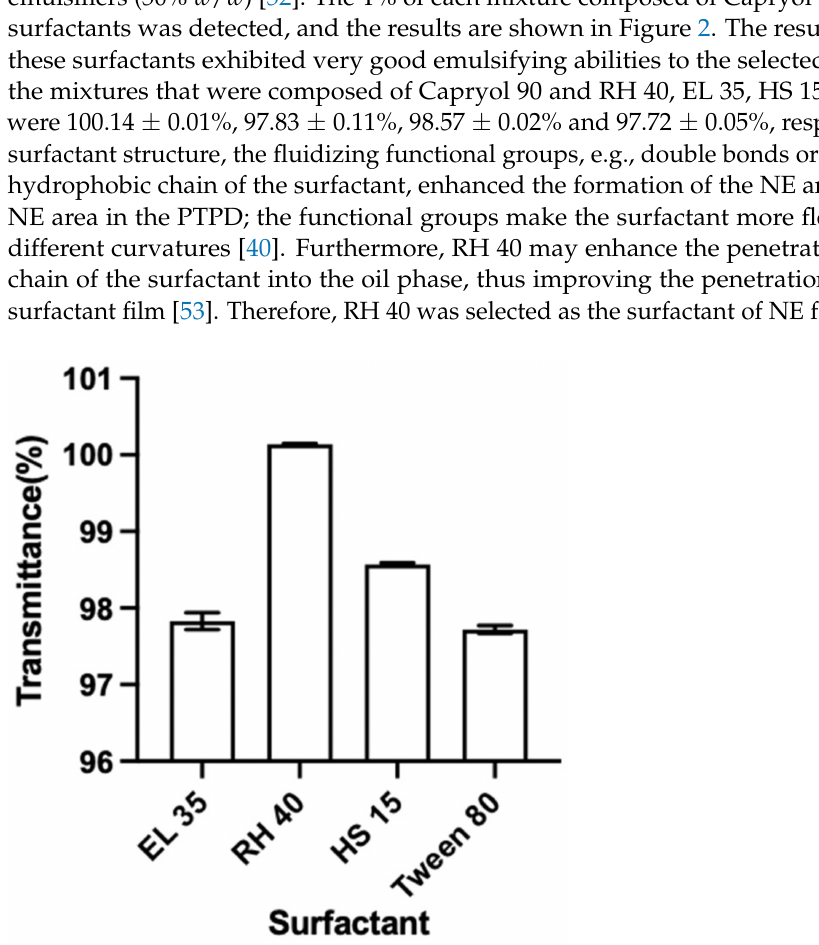
Figure 2. Transmittance (T%) of Capryol 90 with different surfactants (mean ± SD, n =